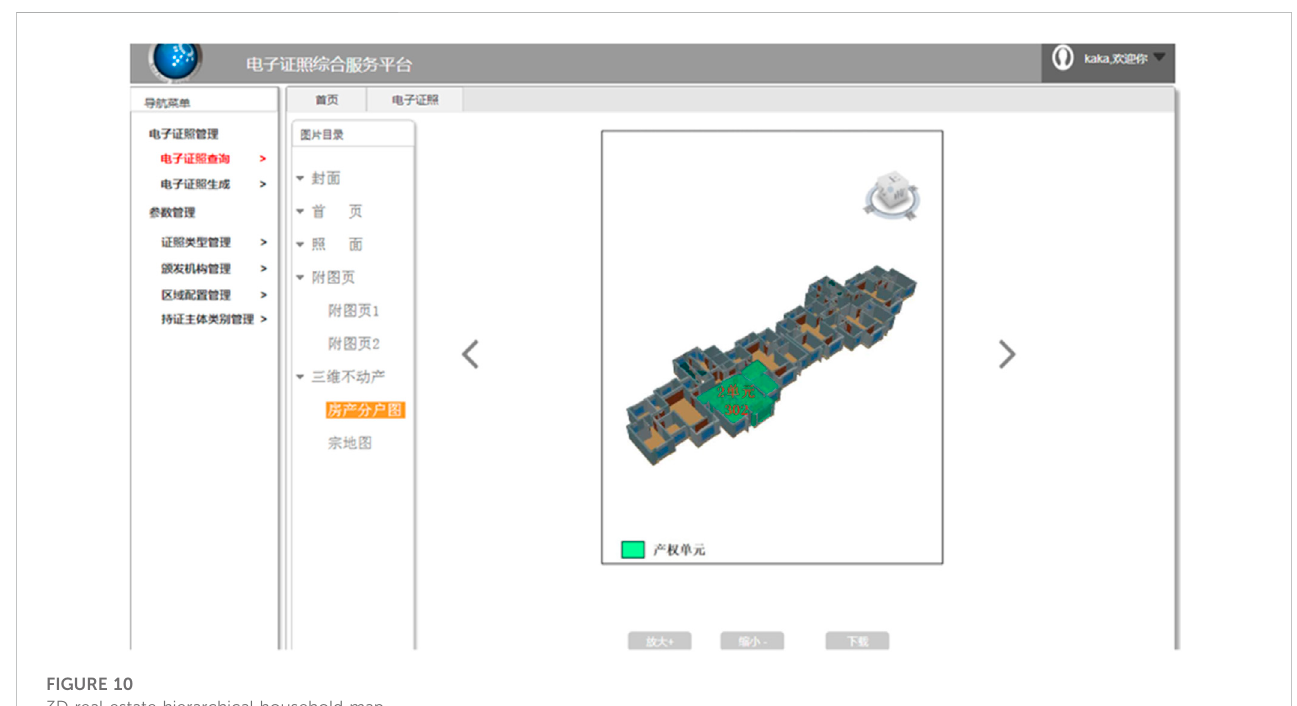
FIGURE 10 3D real estate hierarchical household